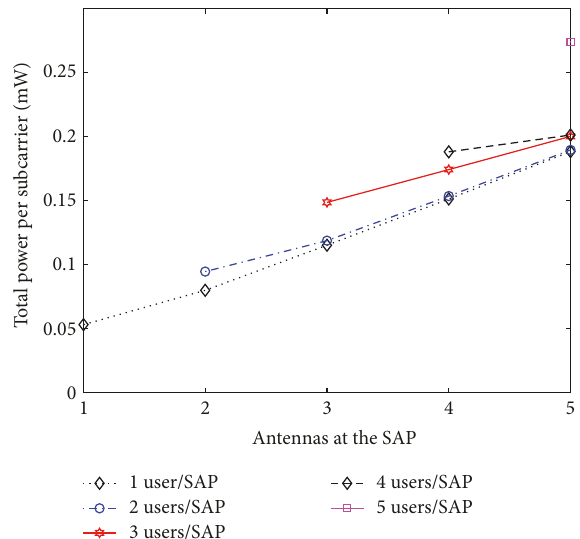
Figure 2: Total power consumption versus the number of antennas per